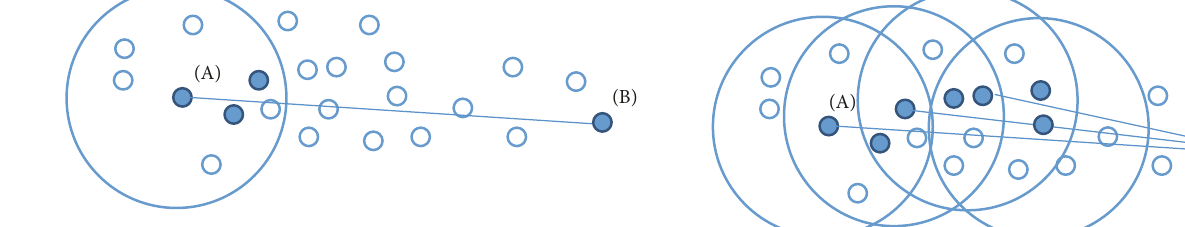
Figure 4: Results of the first slice.